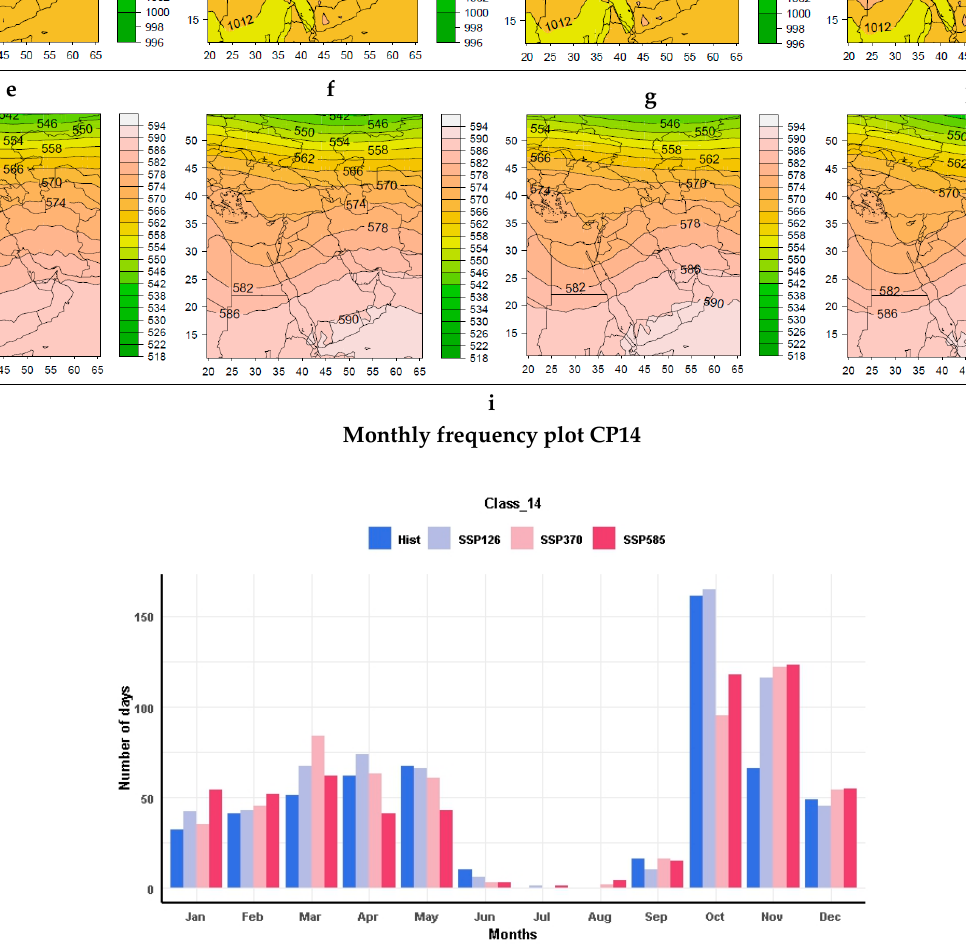
Figure 16. As in Figure 3 for CP14. CP14 occurs most often in autumn and less frequently in winter and spring. The In CP15 (Figure 17), a thermal low-pressure surrounds the east, south, southwest, highest number of occurrences in the historical period is in October, but it shifts to a later and even parts of the west and center of Iran. It also includes Iraq, Saudi Arabia, and the period in the future scenarios, with a maximum in November in SSPs370 and 585. High Red Sea. Isobar 1000 hPa is located on the Persian Gulf, and there is a high pressure in pressure 1020 covers the northern regions of Iran, Turkey, and the western Mediterranean, Southeast Europe to the west of the Black Sea. In future patterns, low pressure strengthens and low pressure is in the south of the Red Sea. The trough is west of the Red Sea at so that the isobar 1000 covers the Persian Gulf, the Oman Sea, southwestern Iran, and the upper level, and a weak ridge extends from the south of Iran to the Caspian Sea. A parts of eastern Saudi Arabia. Moreover, the strengthening of low pressure has caused the strengthening of the subtropical high and an increasing geopotential over the Arabian Sea retreat of high pressure from the Black Sea. At the 500 hPa level, the increase of GPH, will occur in the future (Figure expansion of the high (590 dams) to the northern parts of the country, and the formation of the contour of 594 dams on the Red Sea and Saudi Arabia, as well as in Northeast Africa, signal the warming of the air mass. As expected, the frequency of the occurrence of CP15 is higher in July, June, August, and September. In addition, a relative decrease in the fre- quency of its occurrence can be seen in the future compared to the historical period.